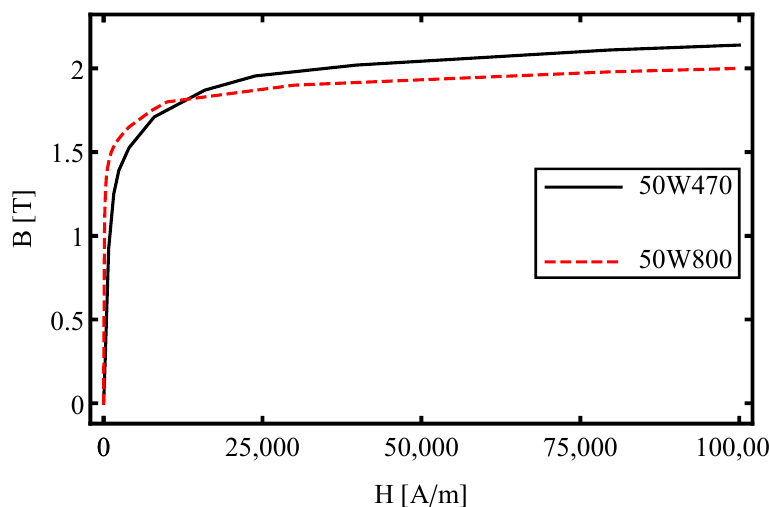
Figure 11. B–H curves for the lamination materials used in Machines I and II.